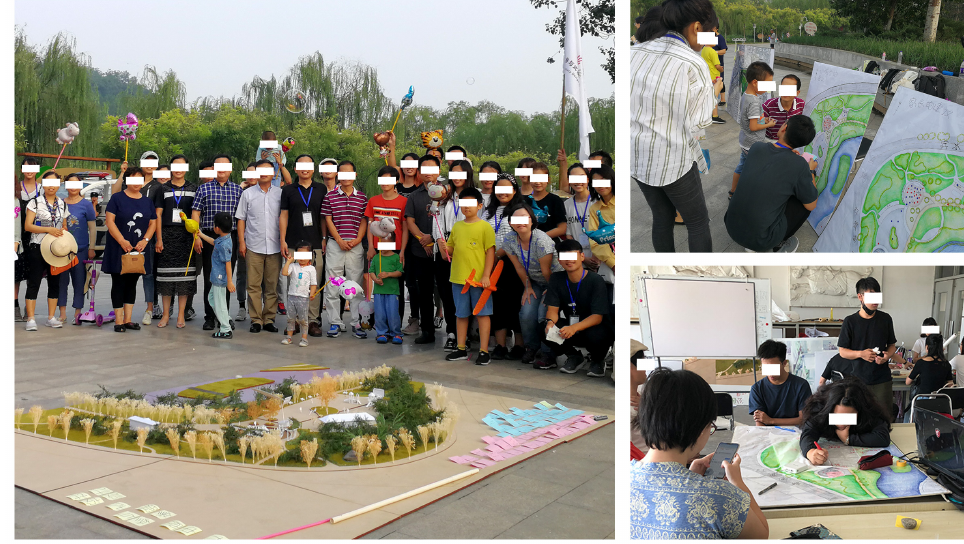
Figure 4. Participatory workshop in Nancuiping